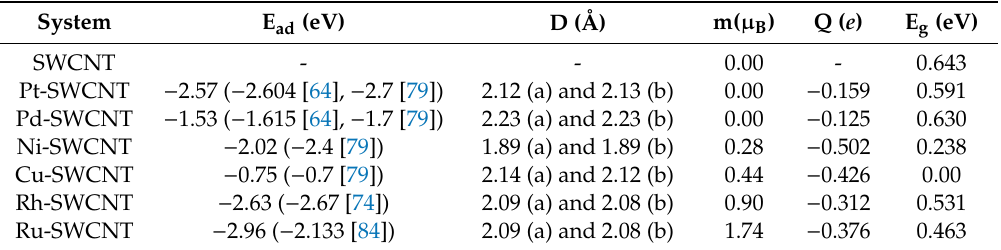
Table 2. The calculated adsorption energy (E ad ), the binding distance between the metal atom and the nanotube (D), magnetic moment (m), charge transfer (Q), energy bandgap (E g ) for the spin-up (-down) channel. The negative values of charge indicate a charge transfer from metal to the nanotube. a: C a atom and b: C b atom in Figure 2a.